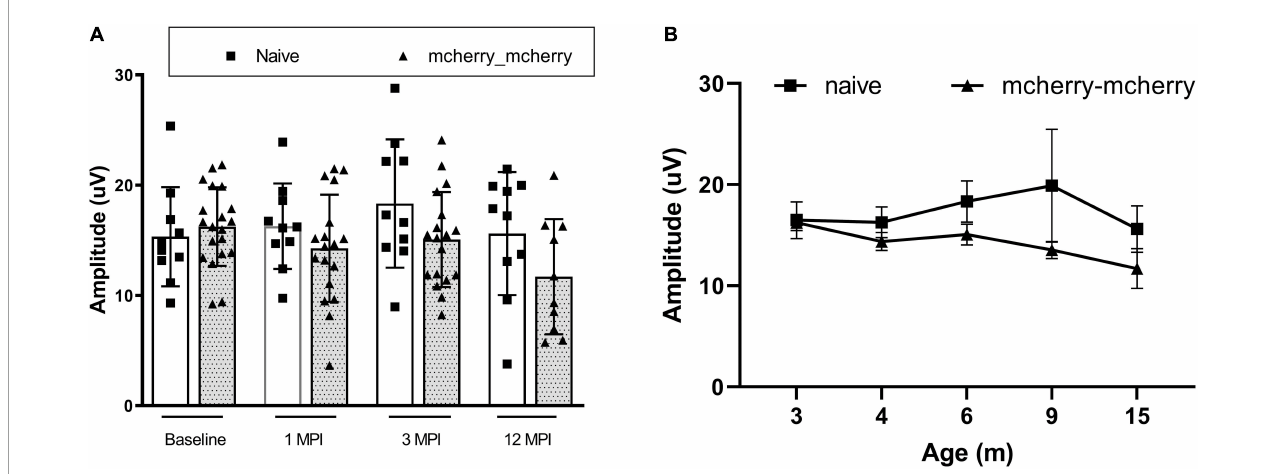
FIGURE1 Double injection does not impair the RGC function. (A) Scatterplot of PERG amplitudes (average of both eyes) of all mice tested in each group shows no significant difference between naïve and mcherry-double injected mice from baseline, 1-, 3-, and 12-month post-injection. (B) A line graph shows the mean PERG amplitude of the mice in both groups did not decrease significantly with age from 3 to 15 months after birth (from baseline to 12 months after injection).